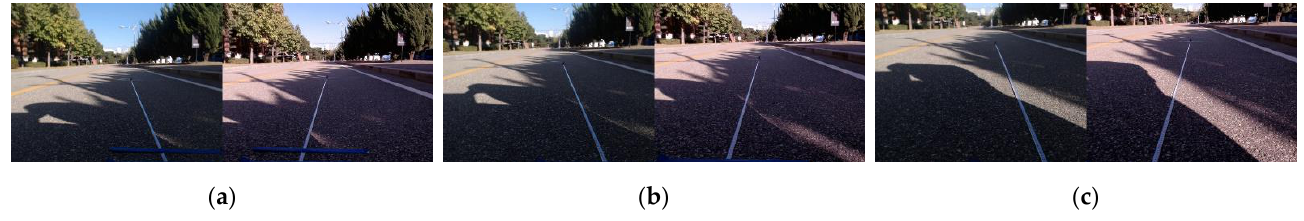
Figure 8. Input images corresponding to different angles: ( a ) corresponding to an angle of 3°, ( b ) corresponding to an angle of 7°, and ( c ) corresponding to an angle of 12°.